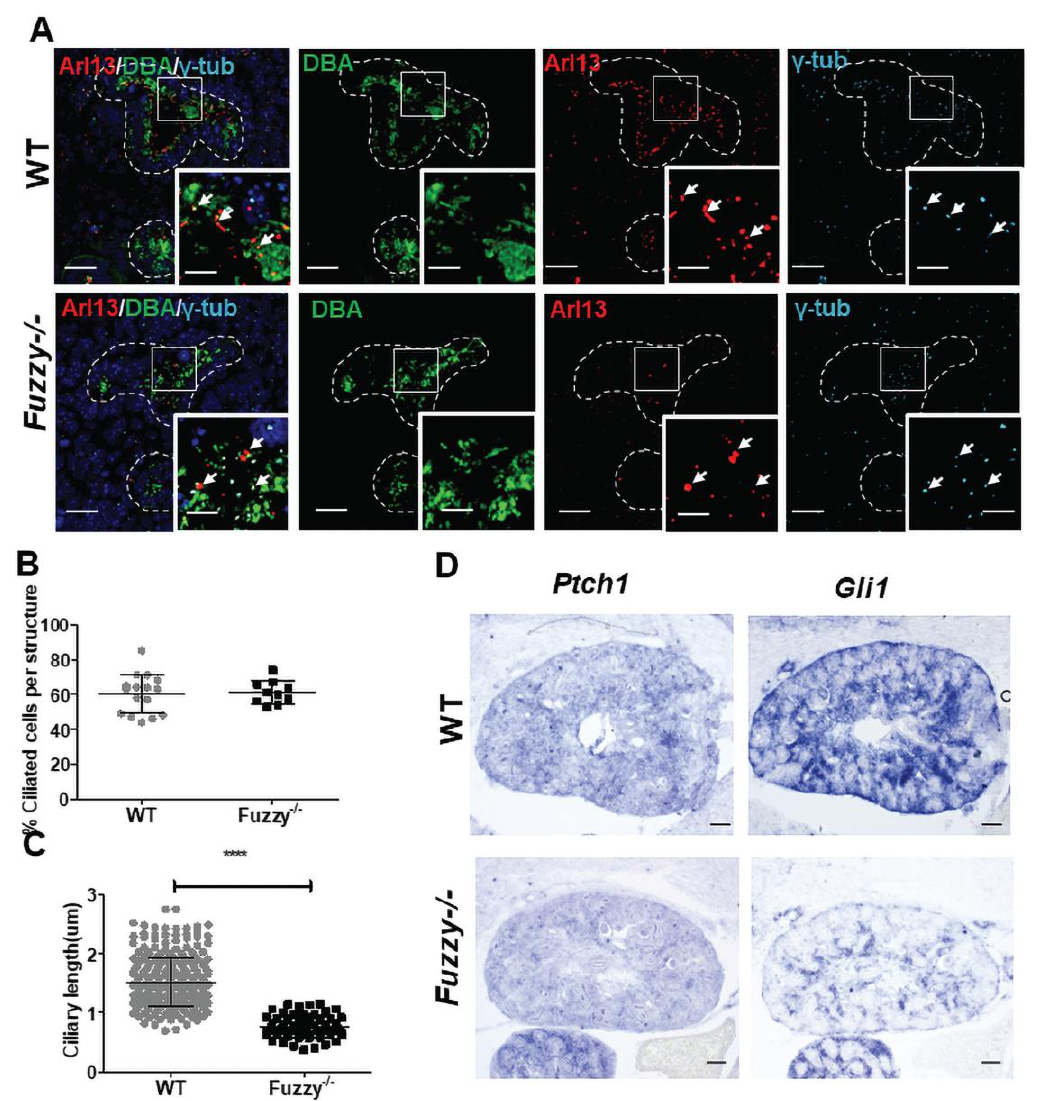
Figure 7. Ciliogenesis and Shh signaling in E14.5 Fuzzy − / − kidneys. ( A ) Confocal images of wildtype and Fuzzy − / − kidney sections immunostained with anti-Arl13b antibody (red) to detect primary cilium and anti- γ -tubulin antibody (light blue) to detect basal body; DBA (green) stains UB cells and DAPI (blue) stains nuclei. Intermittent white lines designate UB structures in which analyses of the ciliary length and numbers were carried out; scale bars = 25 µM. The inserts are the magnified areas within the UB tips designated by the squares. The cilia were counted only if both the Arl13b and γ -tubulin staining were detected for the same cilium; representative cilia/basal bodies are depicted by white arrows; insert scale bars = 8 µM. ( B ) Statistical analysis of ciliated cells in wildtype ( n = 16 tissue fields) and Fuzzy −/− ( n = 10 tissue fields). ( C ) Measurements of ciliary length in UB cells of wildtype (total n = 281 cilia) and Fuzzy −/− (total n = 67 cilia) were made using sections from 4 embryos per genotype. ( D ) In situ hybridization with antisense Ptch1 ( Patched1 ) and Gli1 probes on wildtype and Fuzzy −/− sections; scale bars = 100 µM. 4 WT and 3 Fuzzy −/− embryos were analyzed. **** p 0.0001.